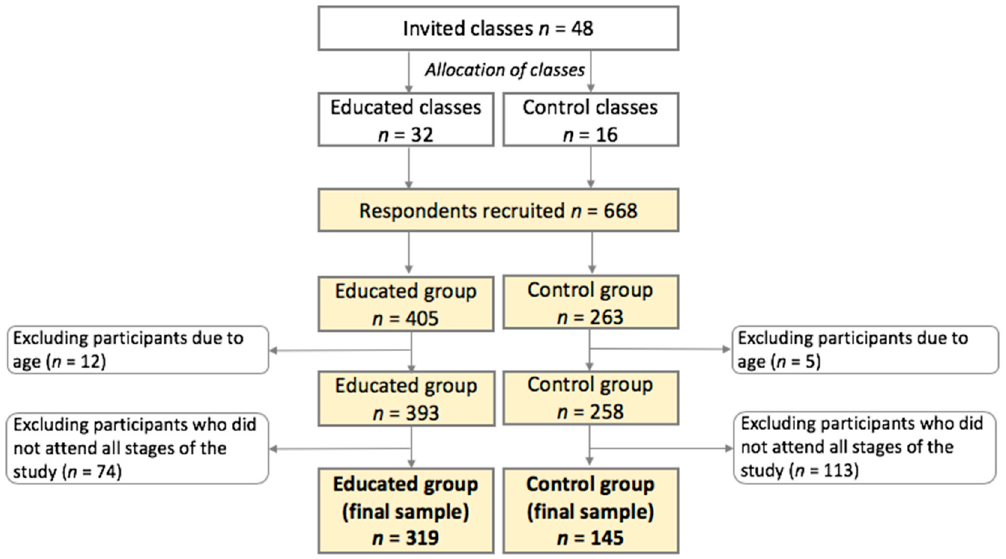
Figure 1. Sample collection. Notes: cream colour indicates respondents and/or study groups.